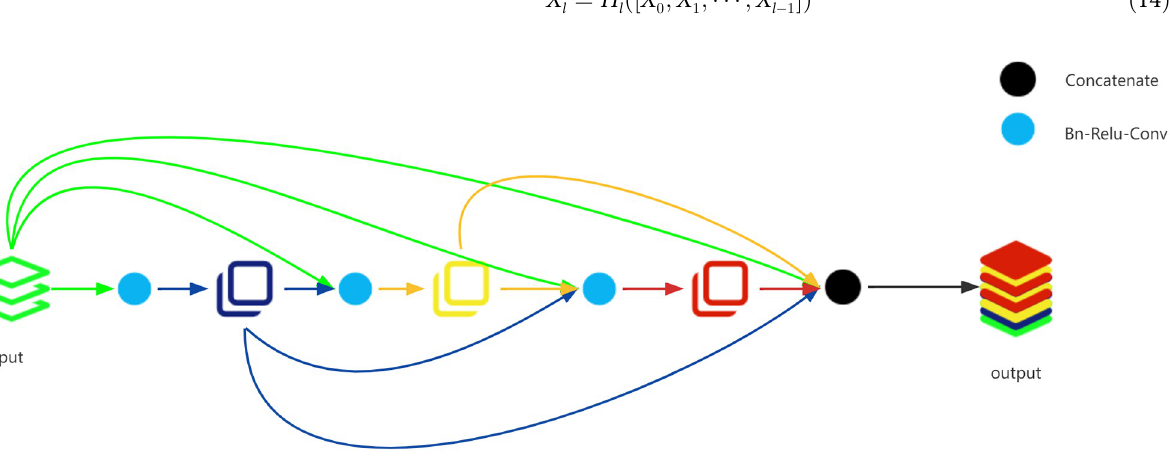
Fig 5. Densely concatenated